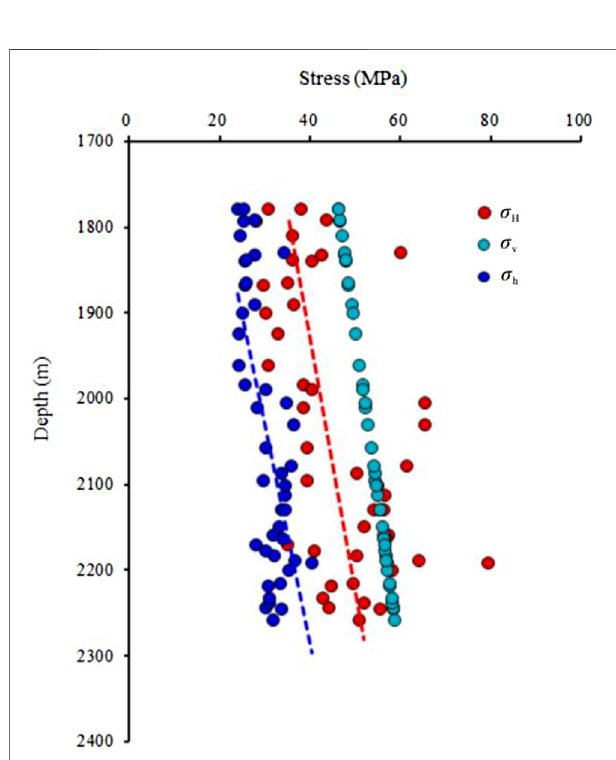
Frontiers in Earth Science |